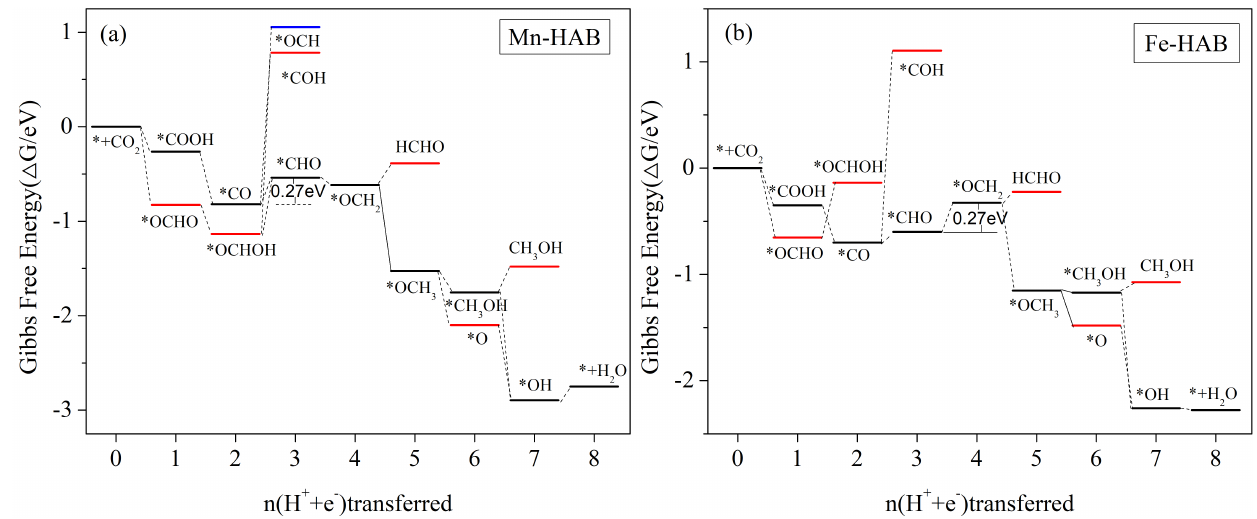
Figure 7. Gibbs free energy curves for ( a ) Mn-HAB and ( b ) Fe-HAB, at zero potential, along the most favorable path of the CO 2 RR. The free energy zero point was set as the carbon dioxide molecule in the gas phase with a clean catalyst